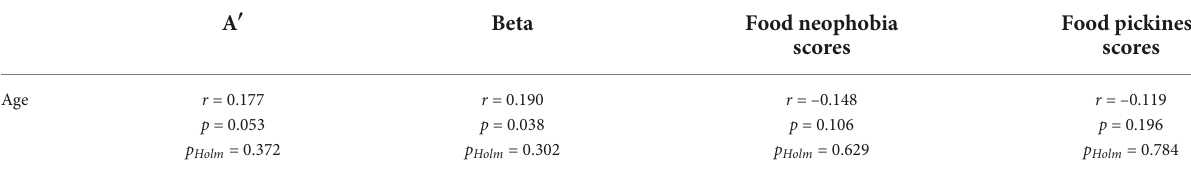
TABLE 2 Pairwise Pearson correlation coefficients between children’s age and their A (cid:48) , Beta, food neophobia, and pickiness scores. A (cid:48) Beta Food neophobia